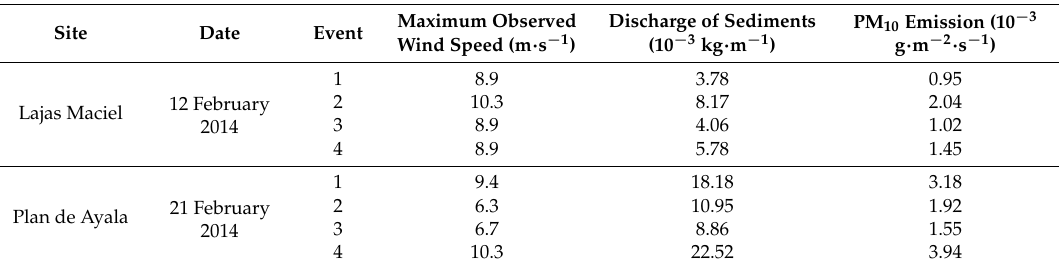
Table 3. Discharge of sediments and calculated PM 10 dust emissions from unpaved roads for eight wind events